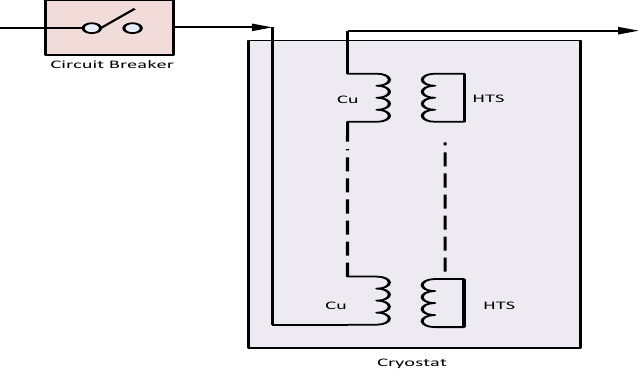
Figure 3. 3.15 kV class inductive SFCL.